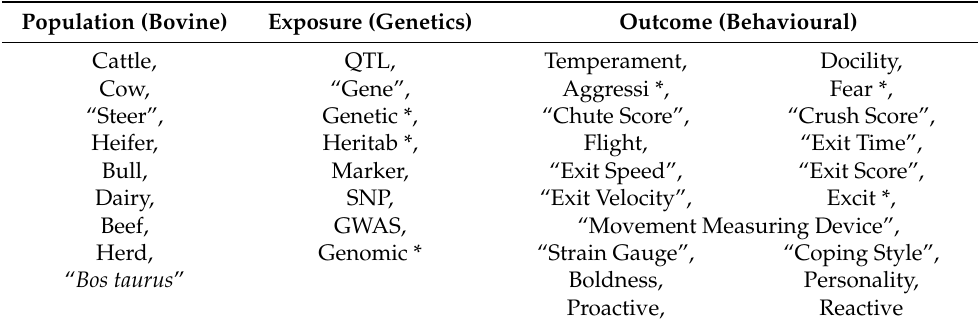
Table 1. The Population, Exposure, Outcome (PEO) framework of terms used in the literature search; the search algorithm was designed using the Boolean operators “AND” & “OR” to ensure that at least one term from each PEO component was returned. Population (Bovine) Exposure (Genetics) Outcome (Behavioural) Cattle, QTL, Temperament, Docility, Cow, “Gene”, Aggressi *, Fear *, “Steer”, Genetic *, “Chute Score”, “Crush Score”, Heifer, Heritab *, Flight, “Exit Time”, Bull, Marker, “Exit Speed”, “Exit Score”, Dairy, SNP, “Exit Velocity”, Excit *, Beef, GWAS, “Movement Measuring Device”, Herd, Genomic * “Strain Gauge”, “Coping Style”, “ Bos taurus ” Boldness, Personality, Proactive, Reactive * Indicates the term is truncated and the ‘wild card’ can represent any character(s); inverted commas indicate that the exact term must be